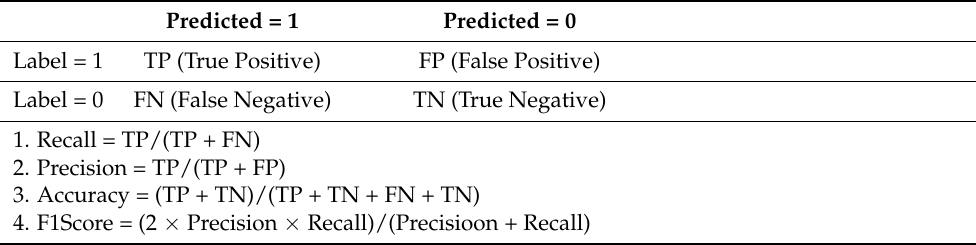
Table 1. Binary confusion matrix